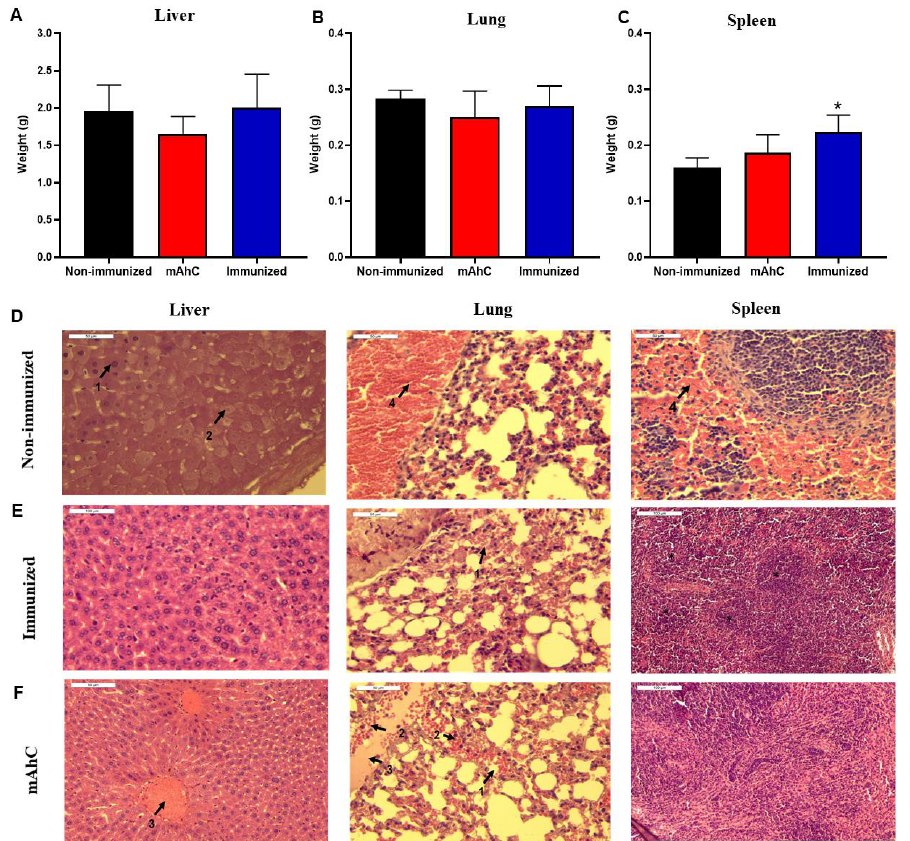
Figure 7. Histopathological findings of A. baumannii infection in CY-treated mice. ( A – C ) Determination of the lung, liver, and spleen weights of CY-treated mice after the application of a lethal dose of A. baumannii (4.0 × 10 8 CFU/mL) using 6 animals per group. Data are expressed as the mean and standard deviation. (*) p < 0.05 represents a comparative analysis between non-immunized CY-treated mice vs. immunized CY-treated mice. ( D – F ) Histopathological findings of experimental groups using CY-treated mice after the application of a lethal dose of A. baumannii (4.0 × 10 8 CFU/mL) stained by the hematoxylin-eosin technique. Data: D1: necrosis (40×), D2: hydropic Degeneration (40×), D3: hyperemia (40×), D4: hemorrhage (40×), E1: hemorrhage (40×), F1: pulmonary hemorrhage (40×), F2: polymorphonuclear neutrophils (40×), F3: acute inflammation (40×), F4: hyperemia (40×), F* white pulp.